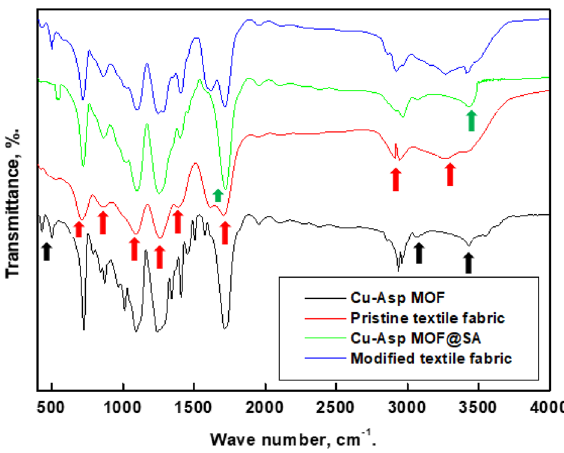
Figure 4. FTIR of the Cu-Asp MOF, Cu-Asp MOF@SA, pristine and modified textile